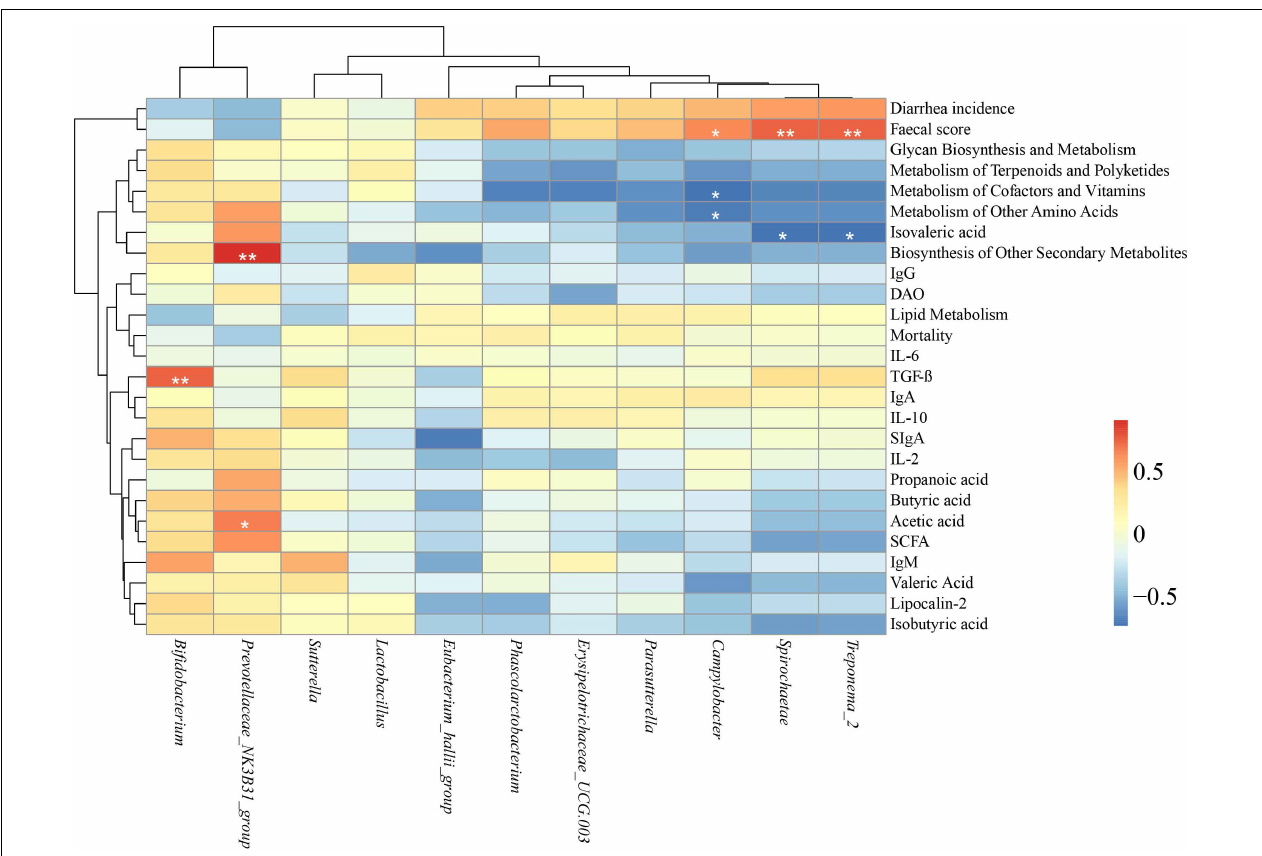
FIGURE 6 | Heatmap of the Spearman rank correlations between the significantly modified microbiota and growth and health parameters in weaning piglets. ∗ P < 0.05, ∗∗ P < 0.01 (following the Spearman correlation analysis). IgG, Immunoglobulin G; IgA, Immunoglobulin A; IgM, Immunoglobulin M; sIgA, secretory IgA; TGF- β , transforming growth factor β ; IL-2, interleukin 2; IL-6, interleukin 6; IL-10, interleukin 10; DAO, diamine oxidase; SCFA, short-chained fatty